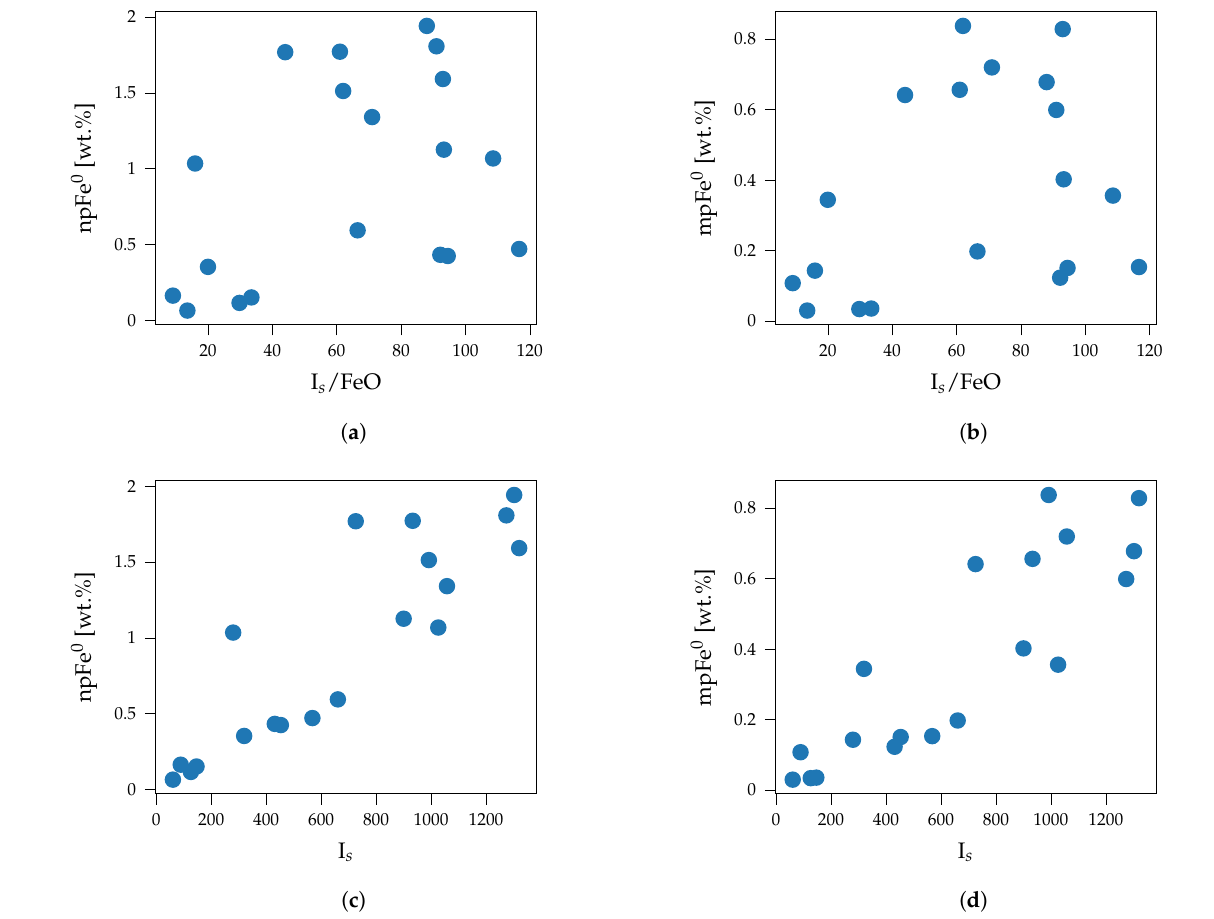
Figure 26. Relationship of npFe 0 and mpFe 0 abundance to the I s /FeO maturity parameter and the ferromagnetic resonance (FMR) I s . The FMR parameter is sensitive to small iron particles in the size range between about 4 nm and 33 nm [57]. The correlation between npFe 0 and I s is clearly visible as well as for the larger mpFe 0 particles. ( a ) npFe 0 , r = 0.39; ( b ) mpFe 0 , r = 0.34; ( c ) npFe 0 , r = 0.88; ( d ) mpFe 0 , r = 0.87.